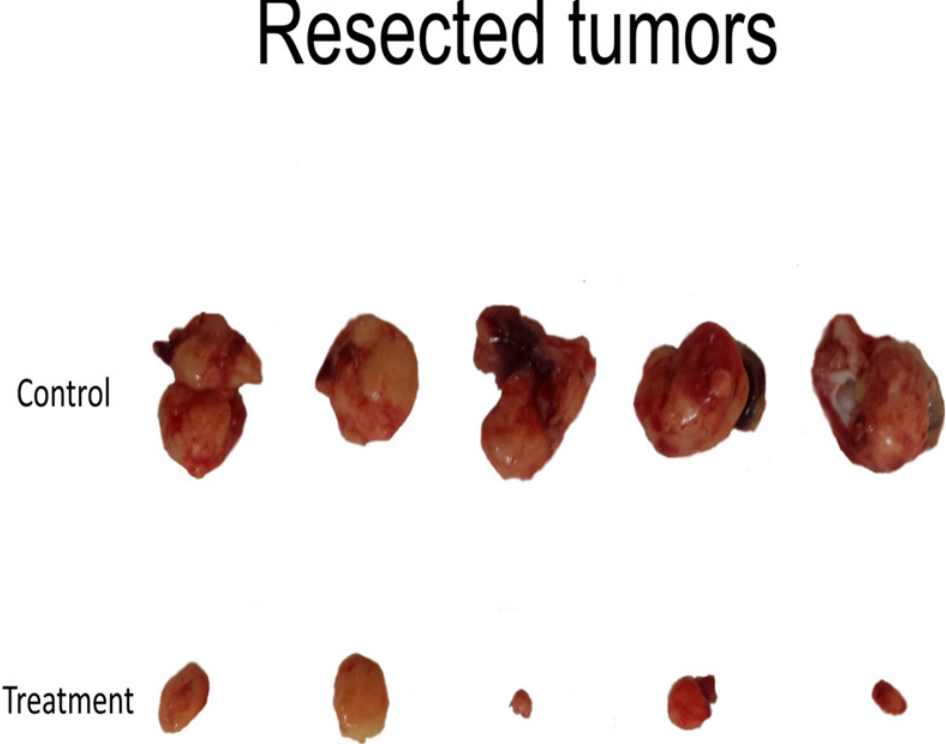
Fig 7. Resected tumors. The top panel shows the tumors from the control group and the bottom panel shows tumors from the treatment